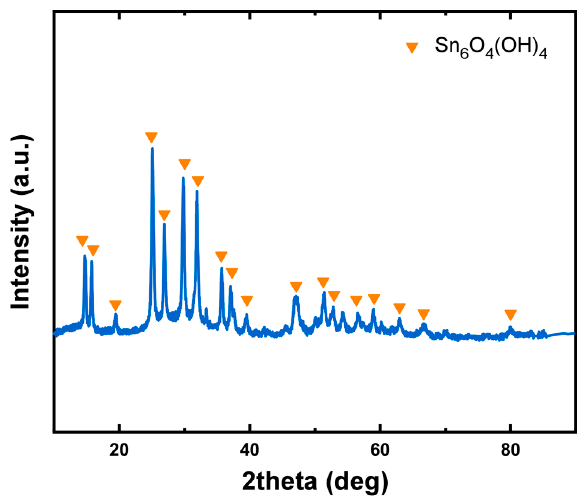
Figure 7. XRD diagram of recovered adsorbent. Table 7. Sn and Cr concentration in solutions and solids produced at reconstruction process in re-